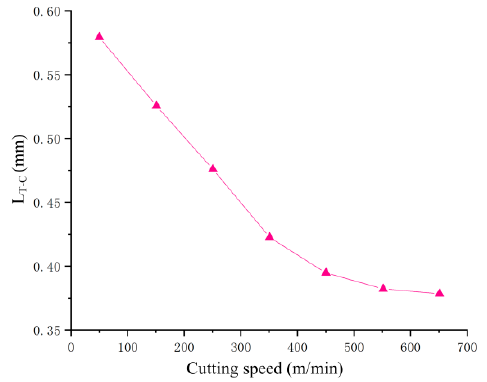
Figure 6. Tool-chip interface contact length in TCI in the model.